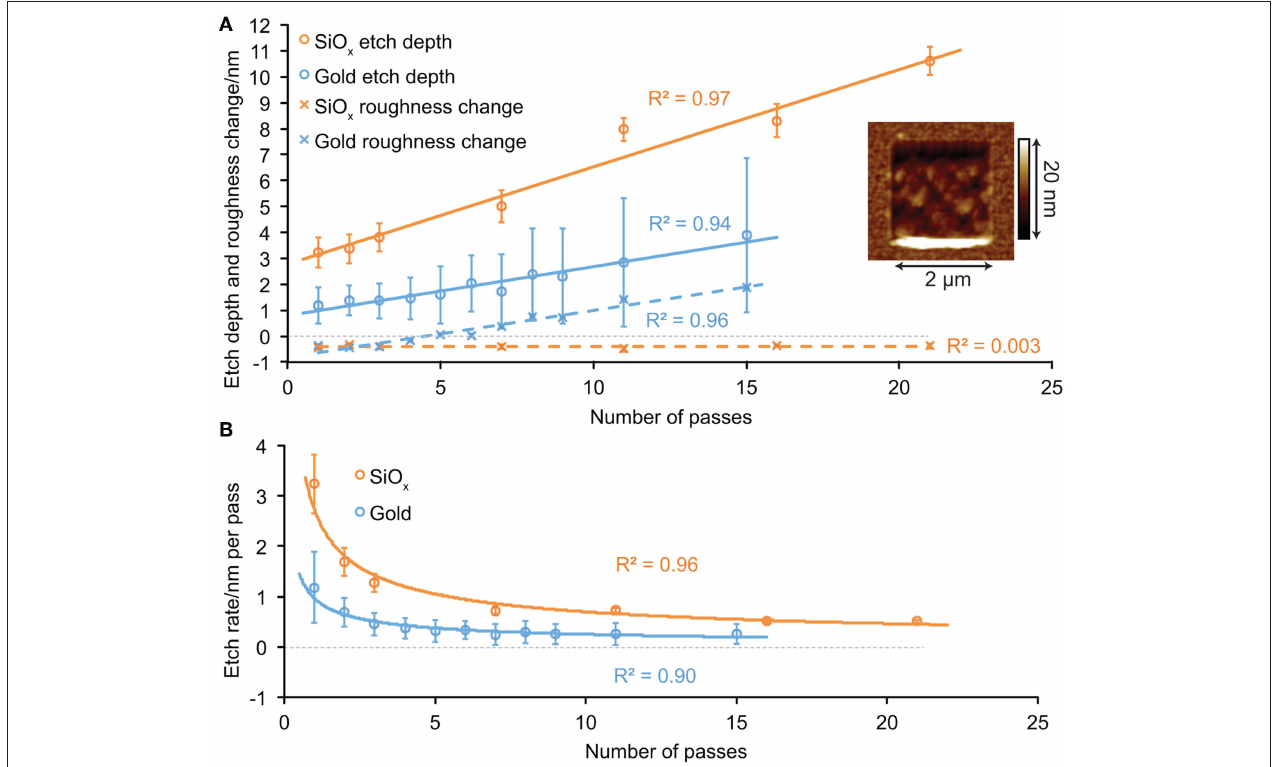
FIGURE 5 | Etch depth and roughness change correlation with number of etching passes for diamond-coated probes applying forces of 4.4 µ N on SiO x and 1.5 µ N on gold. (A) The etch depth for both samples increases linearly with passes. The increasing roughness change with depth demonstrates the extent of the roughening effect on gold, whereas the SiO x is smoothed independently of the depth. Inset—topography of the trench produced from 15 passes on gold, demonstrating a deep depression at one edge extending around 10nm below the surface. (B) The etch rate (trench depth divided by number of passes) decreases inversely with the number of passes. This is likely because there is a non-zero minimum etch depth and a linear increase of depth with number of passes, so the ratio between depth and passes